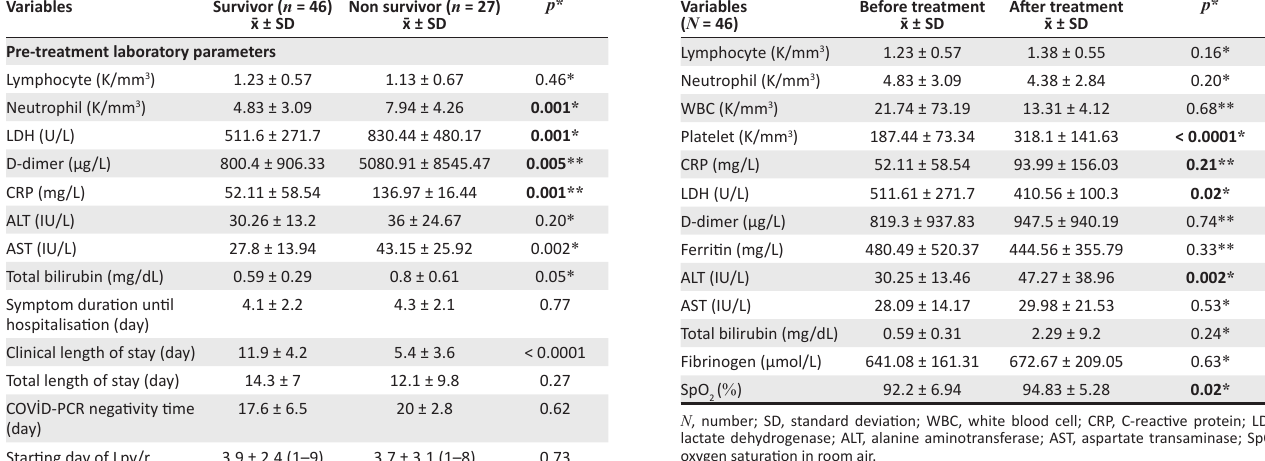
TABLE 2: Comparison of laboratory and treatment parameters patients treated with lopinavir/ritonavir. Variables Pre-treatment laboratory parameters